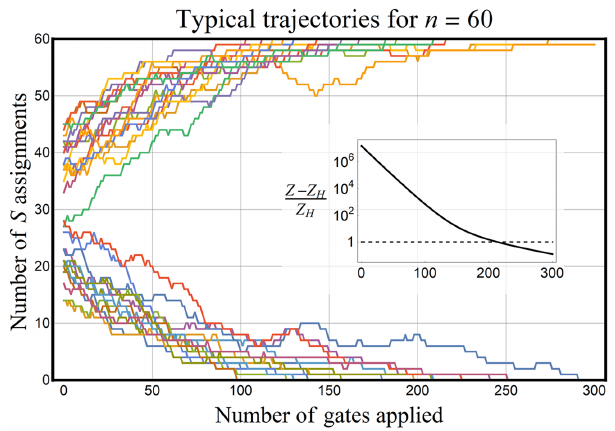
FIG. 3. Thirty trajectories generated randomly for the complete-graph architecture at n = 60. A trajectory γ is chosen with probability proportional to weight (γ ) in the s → ∞ limit and then the number of S assignments (out of 60) are plotted for the first 300 time steps. The trajectories rapidly approach either the fixed point I n with 0 S assignments, or the fixed point S n with 60 S assignments but not all have reached the fixed point within 300 time steps. The distance of a typical trajectory from the nearest fixed point decays exponentially with time, with characteristic time scale (cid:3)( n ) . Thus, it takes (cid:3)( n log ( n )) gates for most typical trajectories to have reached the fixed point. In the inset, it is shown that as trajectories approach the fixed points, the collision probability Z (which can be efficiently numerically calculated for the complete-graph architecture) approaches Z H . Anticoncentration is defined as the point where it falls beneath 2 Z H (dashed line), which occurs at s = 214 for n =